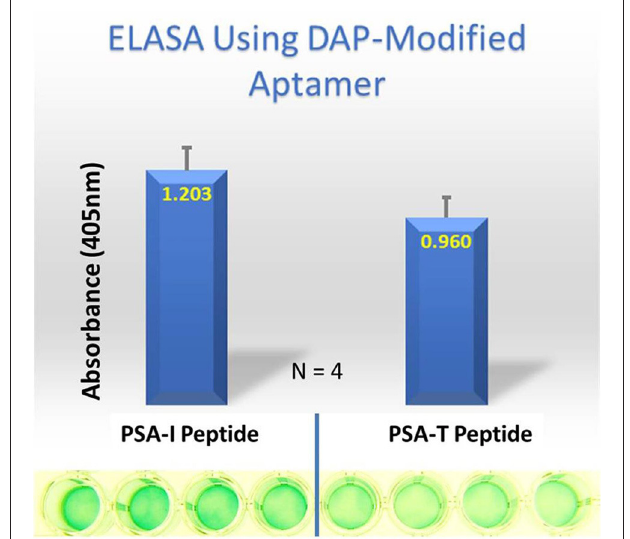
FIGURE 7 | ELASA results demonstrating differential binding of the DAP-modified aptamer to the PSA variant peptides. The DAP-modified aptamer demonstrated ∼ 20% greater affinity for the PSA-isoleucine (I) vs. the PSA-threonine (T) variant. Bar heights and error bars represent the Means ± 2 Standard Deviations of four independent enzyme-linked (ELASA) absorbance at